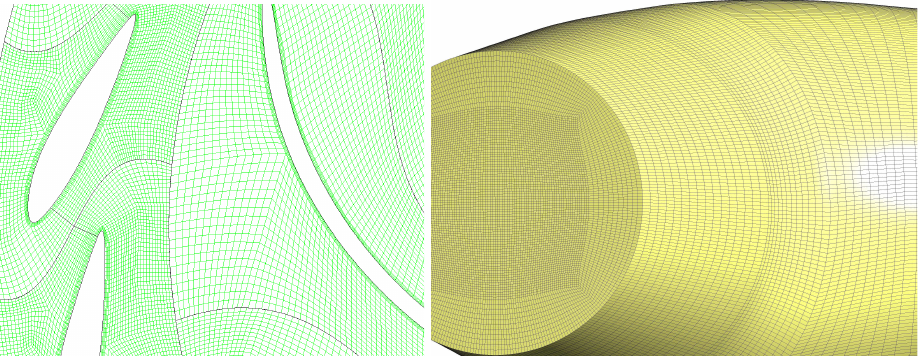
Figure 4. Details of the mesh in the guide vane, runner and draft